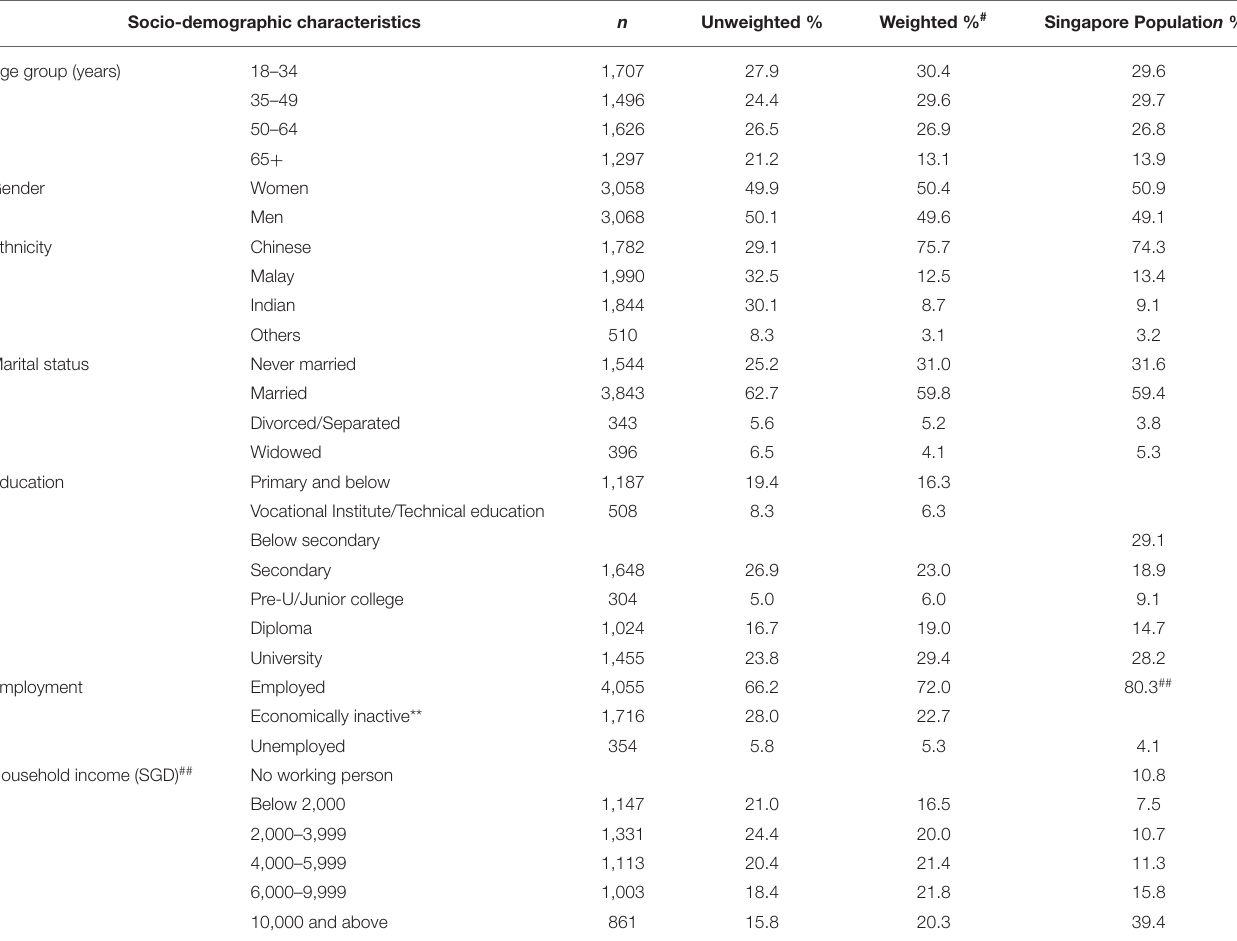
TABLE 1 | Socio-demographic distribution of the sample ( n = 6,126). Socio-demographic